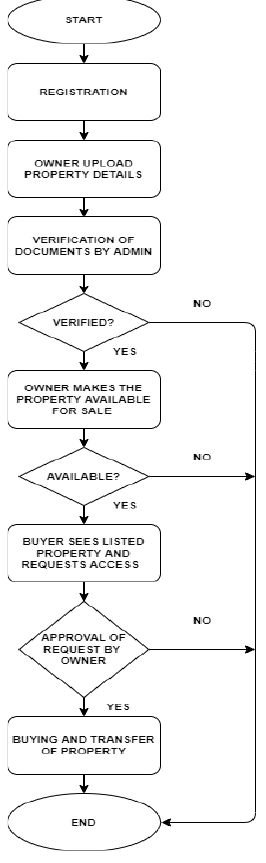
Fig 1 : flow chart of asset transaction using